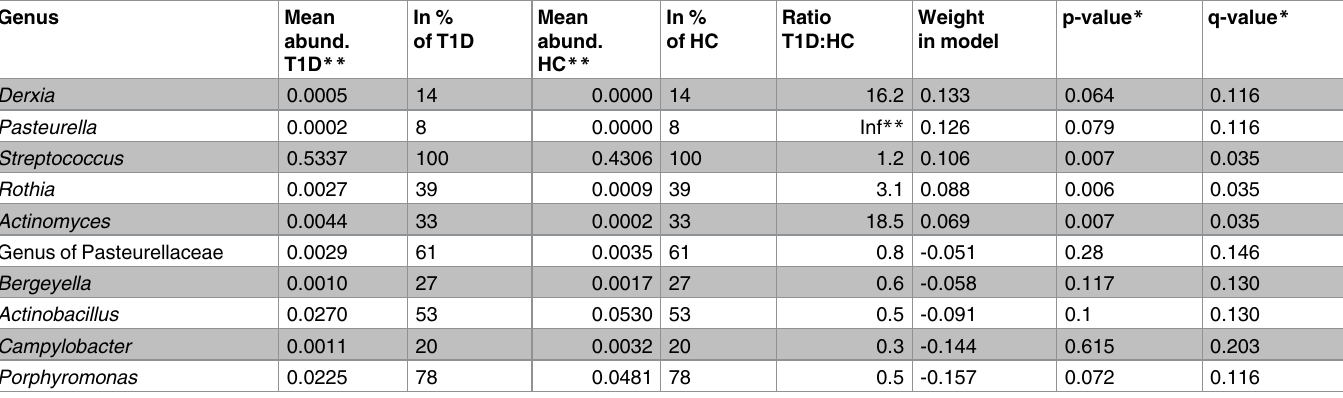
Table 3. Most discriminating oral genera from elastic net